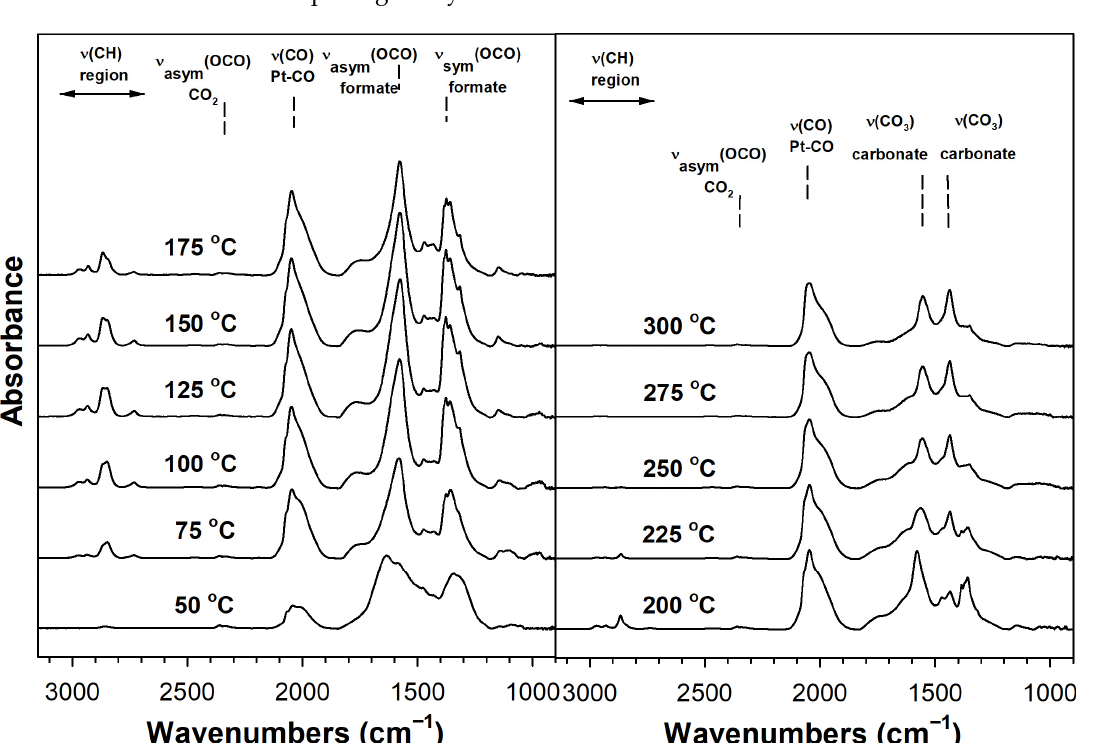
Figure 3. DRIFTS of steam reforming of formaldehyde over 0.5%Na-2%Pt/m-ZrO 2 .